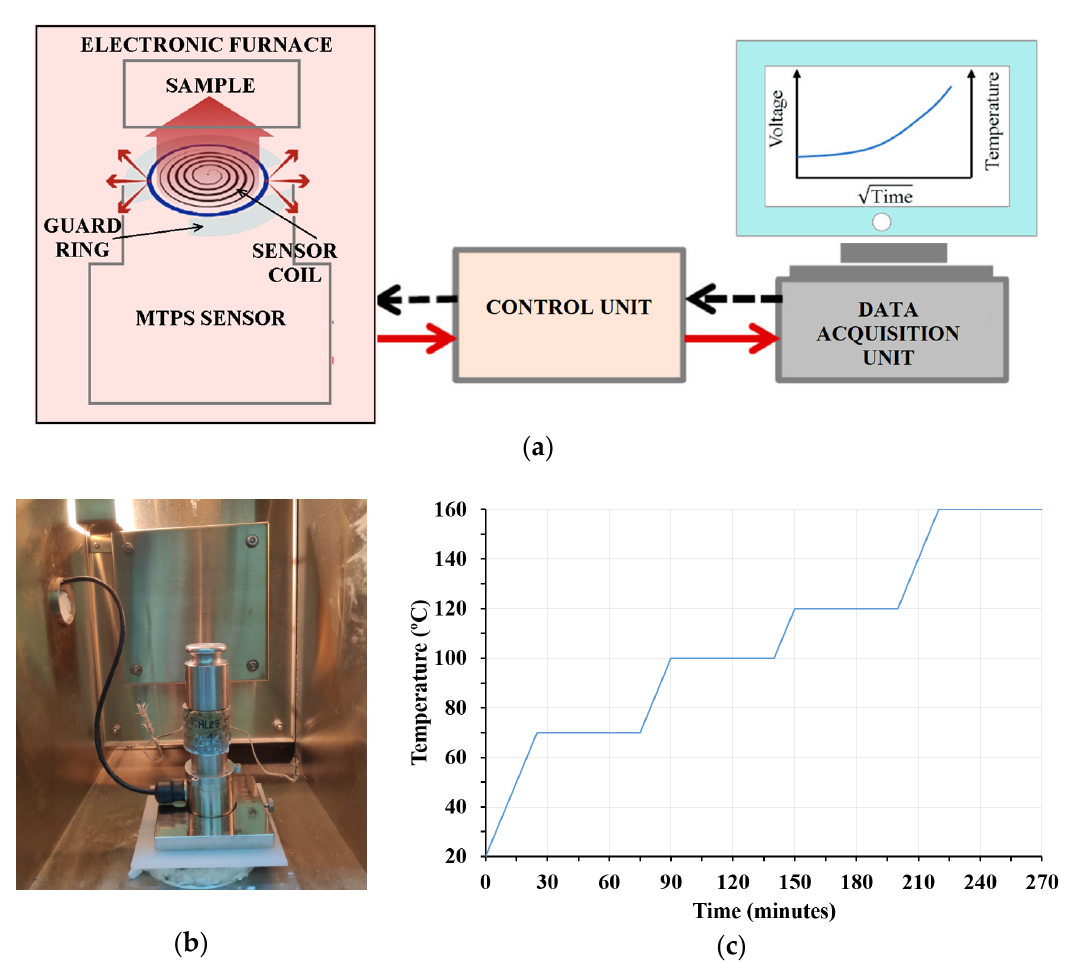
Figure 3. MTPS Test: ( a ) configuration of test; ( b ) placing of the sample in the chamber; ( c ) temperature curve set.